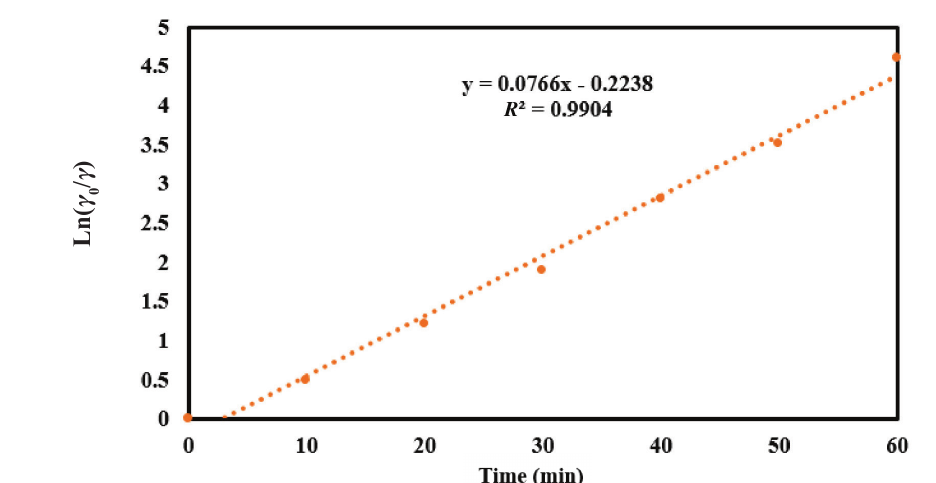
Fig. 8 – First order kinetic model of CWPO/US-Fe